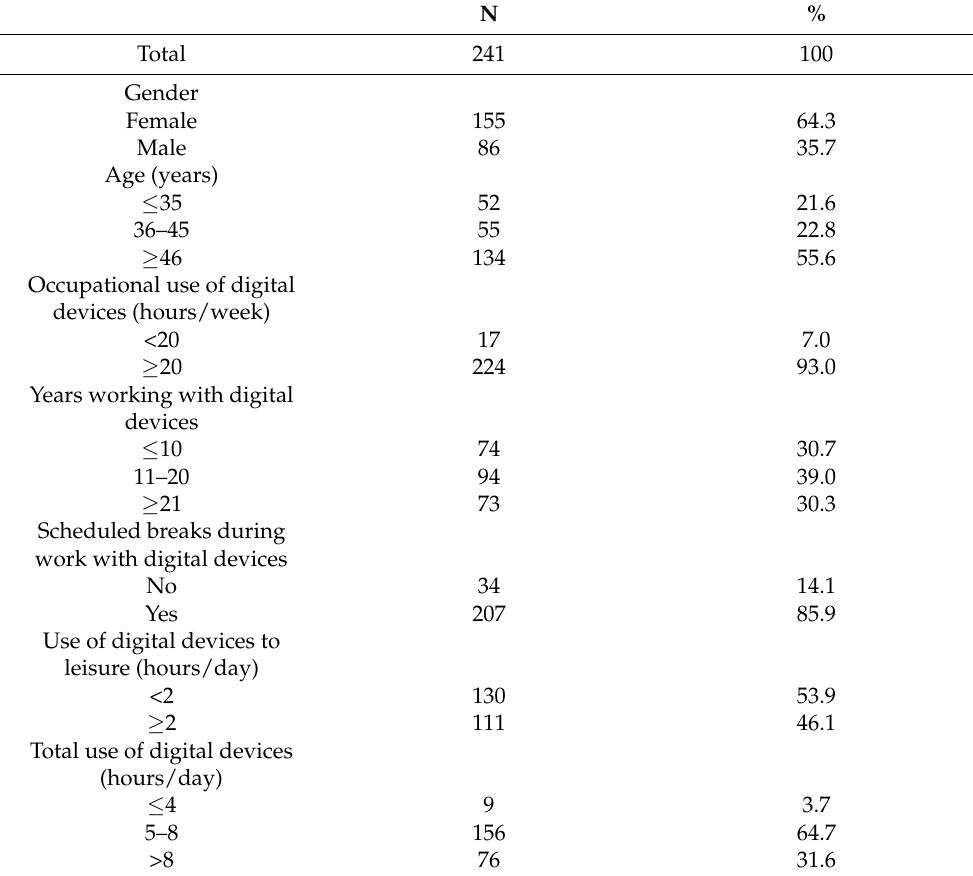
Table 2. Sociodemographic characteristics and exposure to digital devices of the study